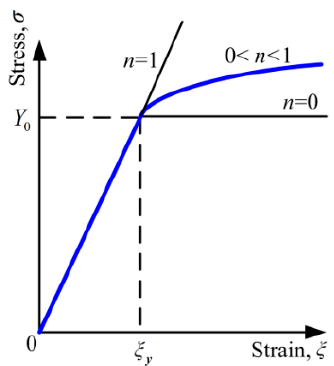
Figure 1. The constitutive law of power-law hardening elastic–plastic materials.